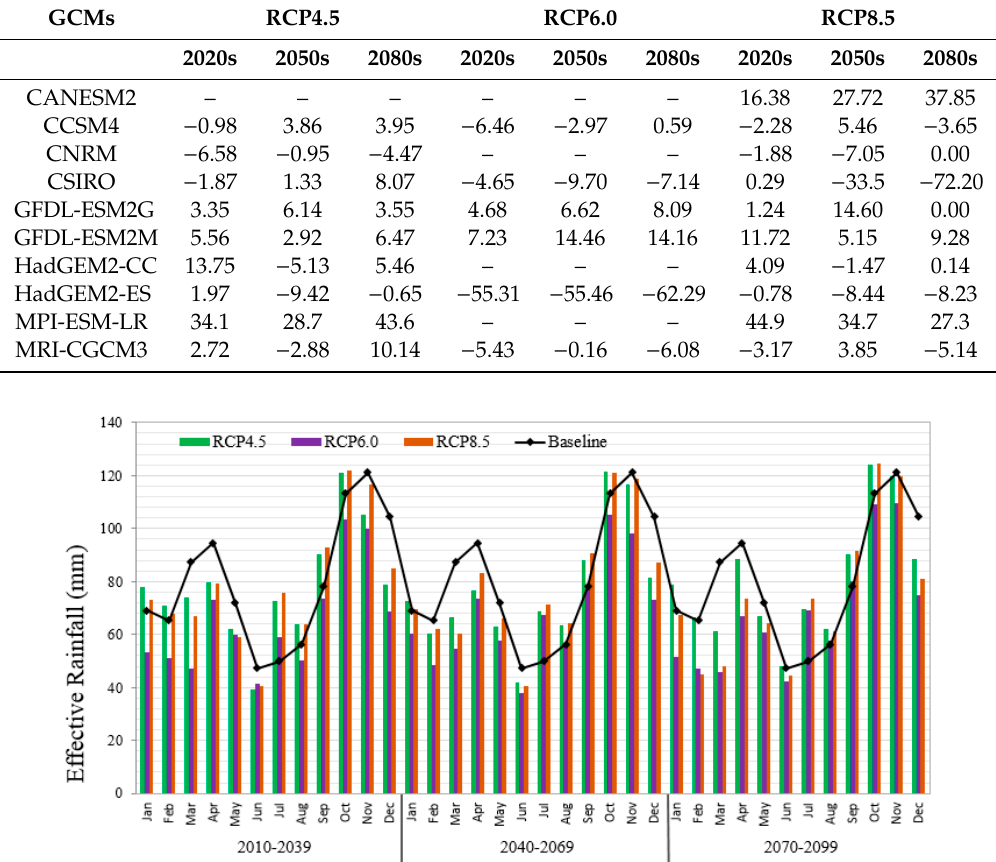
Table 2. Projected annual changes in e ff ective rainfall (%) by global climate models (GCMs) under Representative Concentration Pathways (RCPs) 4.5, 6.0, and 8.5 for the periods 2010–2039, 2040–2069, and 2070–2099 relative to the 1976–2005 baseline period.